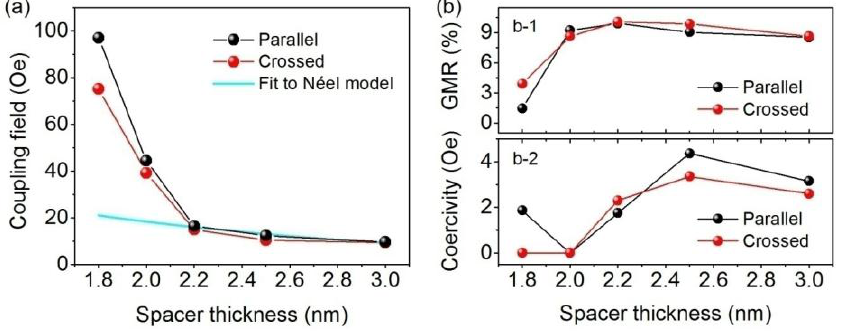
Figure 2. ( a ) Ferromagnetic coupling field as a function of the spacer thickness for spin valve sensors with the parallel anisotropy configuration, as well as the fit of the data to the Néel model. Lines connecting the symbols are a guide to the eyes; ( b ) GMR ratio (b-1), as well as the coercivity of the free layer (b-2) as a function of the spacer thickness for spin valve sensors of parallel and crossed anisotropy